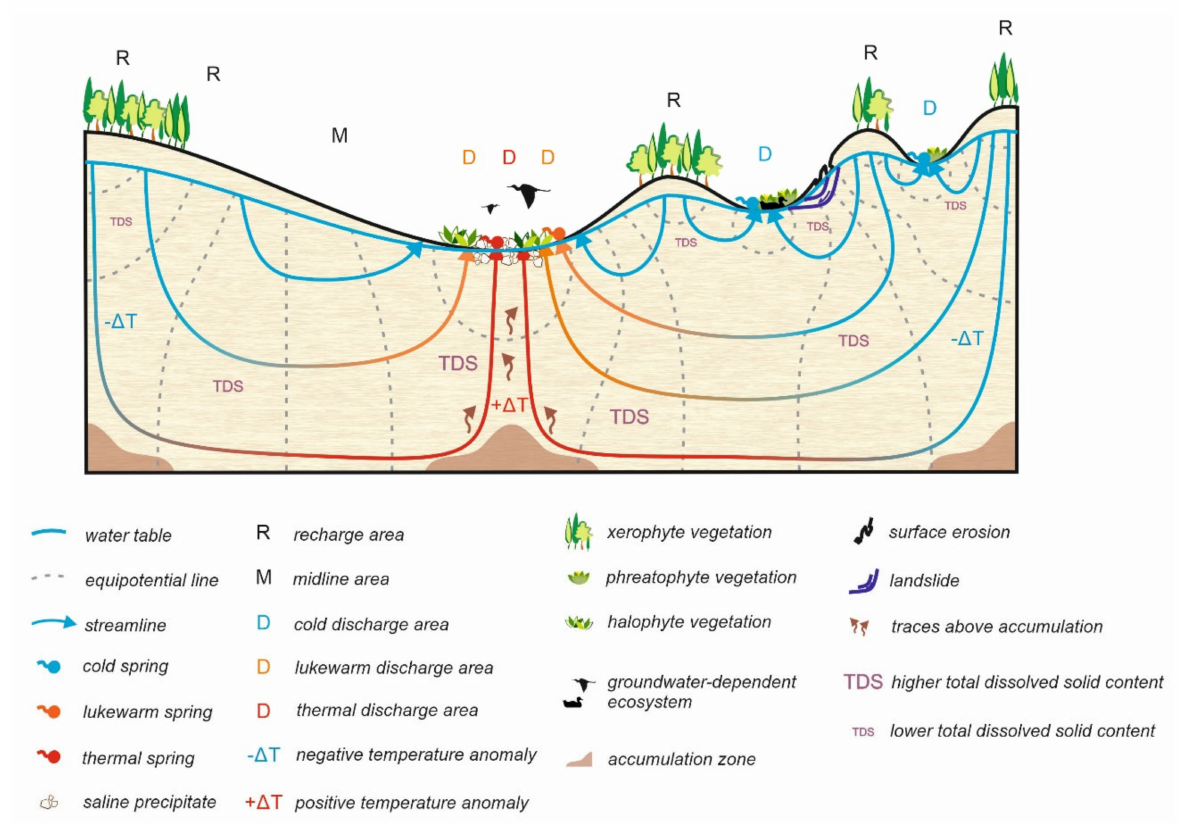
Figure 1. Gravity-driven groundwater flow systems in sedimentary basins and the related natural phenomena (half-basin on the left-hand side: unit basin, half-basin on the right-hand side: composite basin)